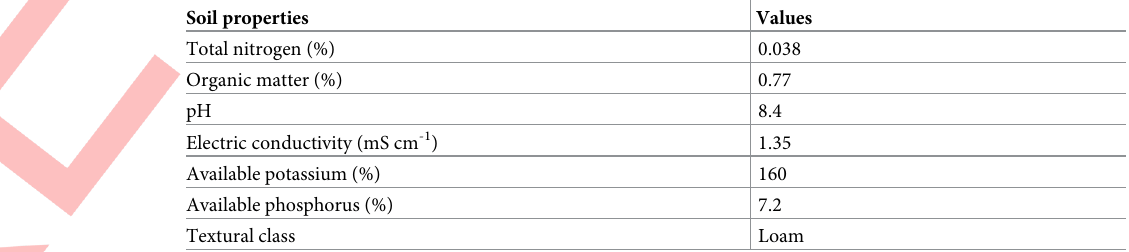
Table 1. Physio-chemical parameters of experimental soil. Soil